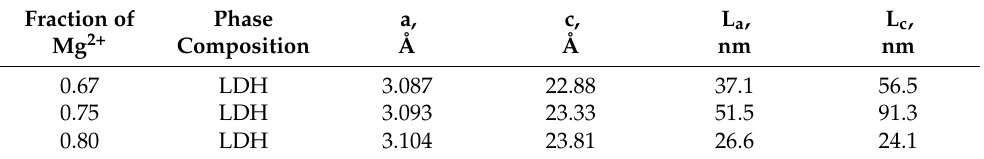
Table 1. Lattice constants a, c (hydrotalcite) and average crystallite sizes L a , L c of MgGa-CO 3 LDHs. Fraction of Mg 2+